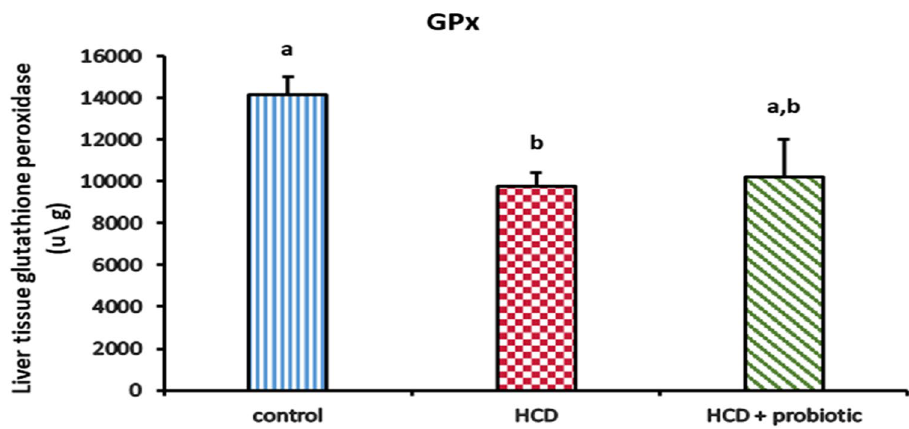
Figure 13. Effect of HCD and HCD with probiotic supplementation on liver antioxidant [Glutathione Peroxidase